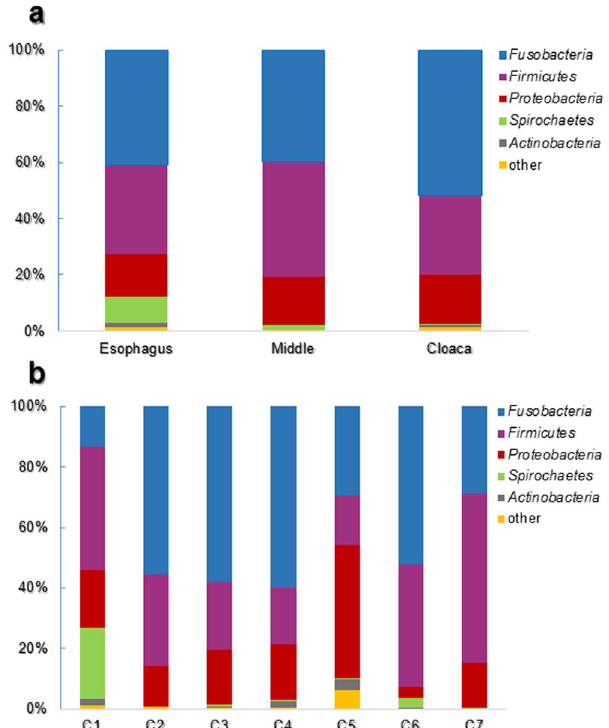
Figure 2. Average OTU abundances at the phyla level. ( a ) Sum of all the samples from a specific section (esophagus, middle, cloaca) of the cormorant intestine. Fusobacteria , Firmicutes Actinobacteria and Proteobacteria showed no significant differences in the different intestine parts (p > 0.05). However, Spirochaetes phylum evinced significant differences in relative abundance in the different intestine parts (repeated measures ANOVA: F 2,10 = 4.84, p = 0.034). ( b ) Sum of the phyla abundances from the three sampled areas (esophagus, middle, cloaca) for each individual cormorant. Fusobacteria was the most abundant phylum in birds C2,